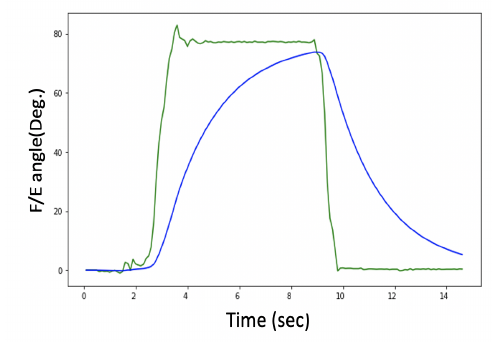
Figure 8. Delay problem with Acc. readings.